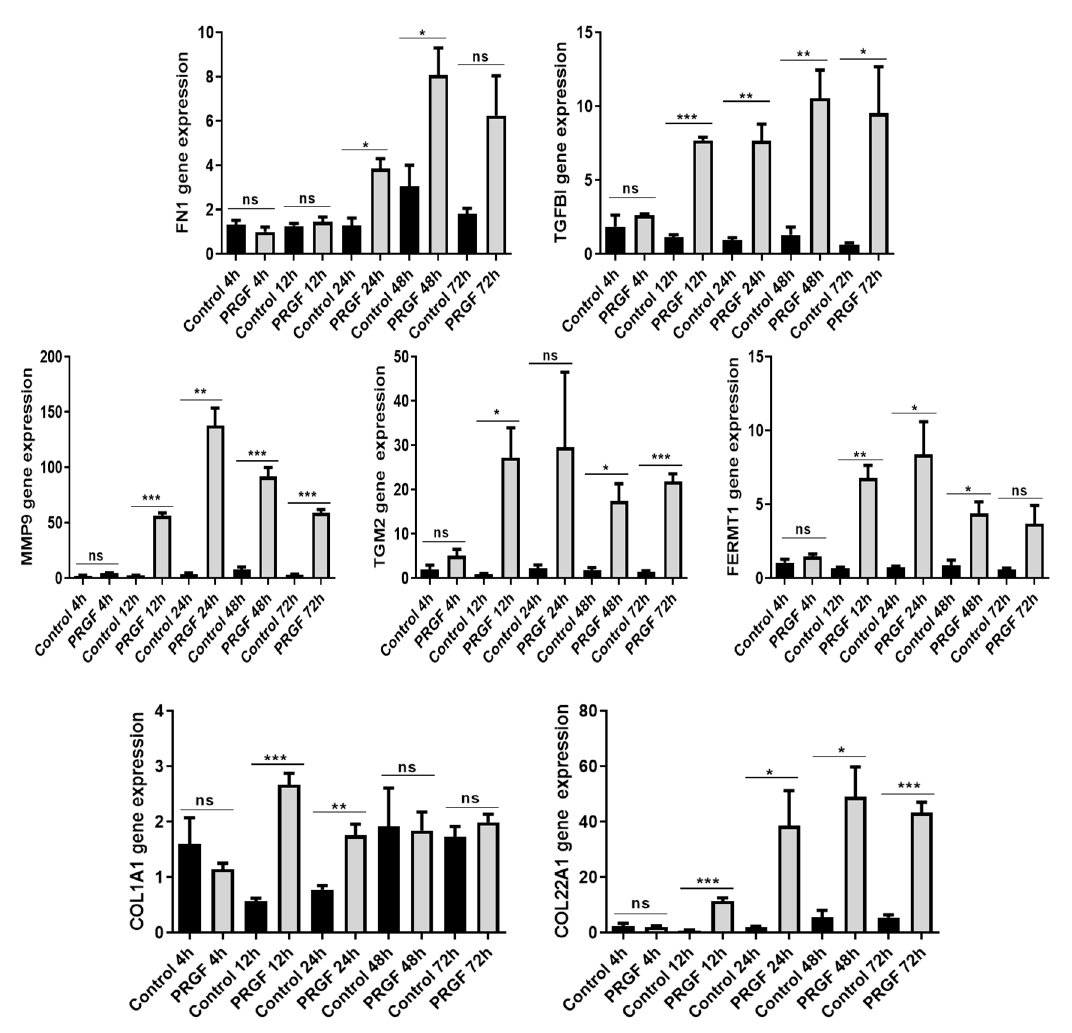
Figure 3. Time kinetics of PRGF-induced ECM-related proteins in human keratinocytes. Human primary keratinocytes were stimulated with PRGF for the indicated periods. Relative gene expression was analyzed by real-time PCR. Shown are means ± s.e.m of three stimulations (* p < 0.05, ** p < 0.01, *** p < 0.001; ns = non-significant; Student’s t -test).